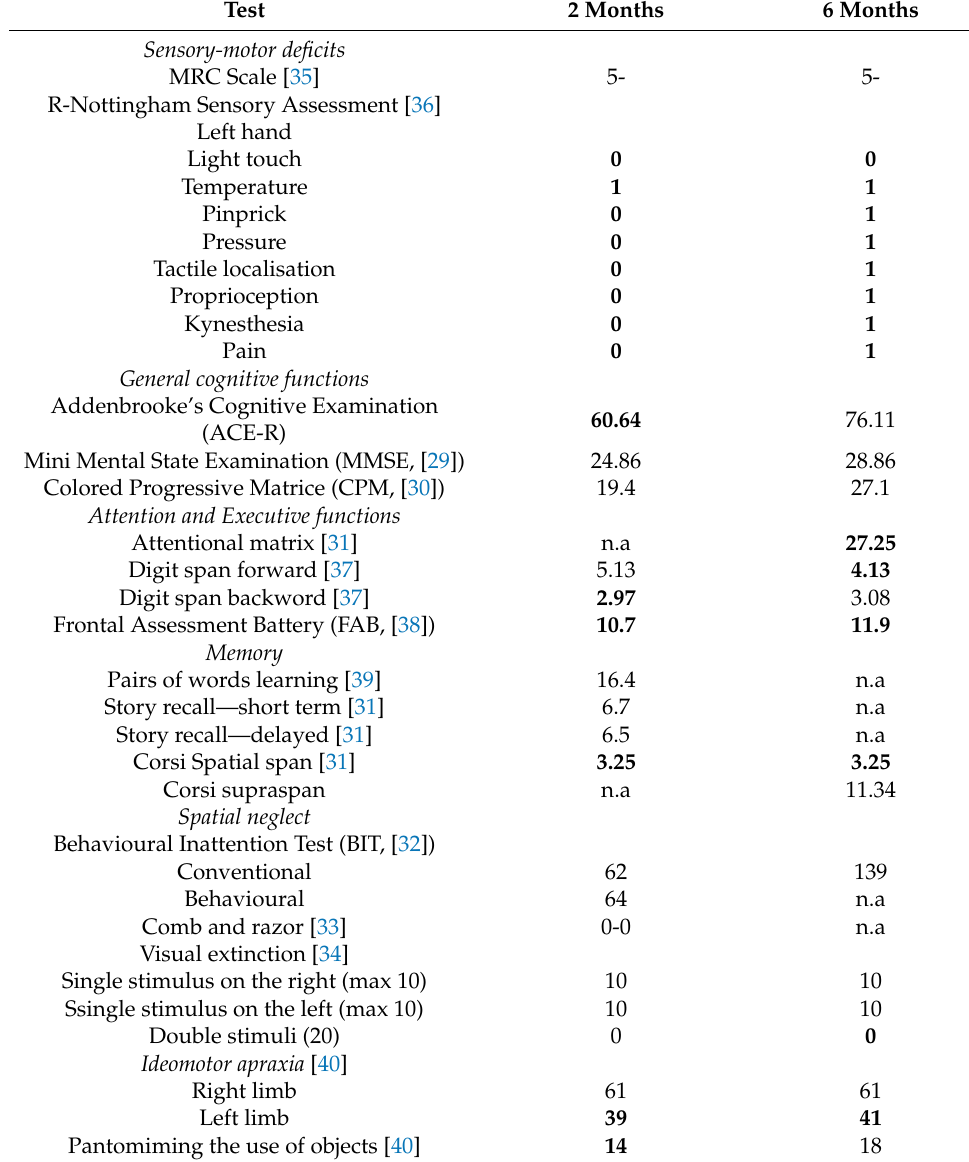
Table 2. Neurological and neuropsychological assessment. BG’s performance in sensory-motor and neuropsychological tasks carried out 2 and 6 months after lesion onset was reported. The scores are corrected for age, gender, and